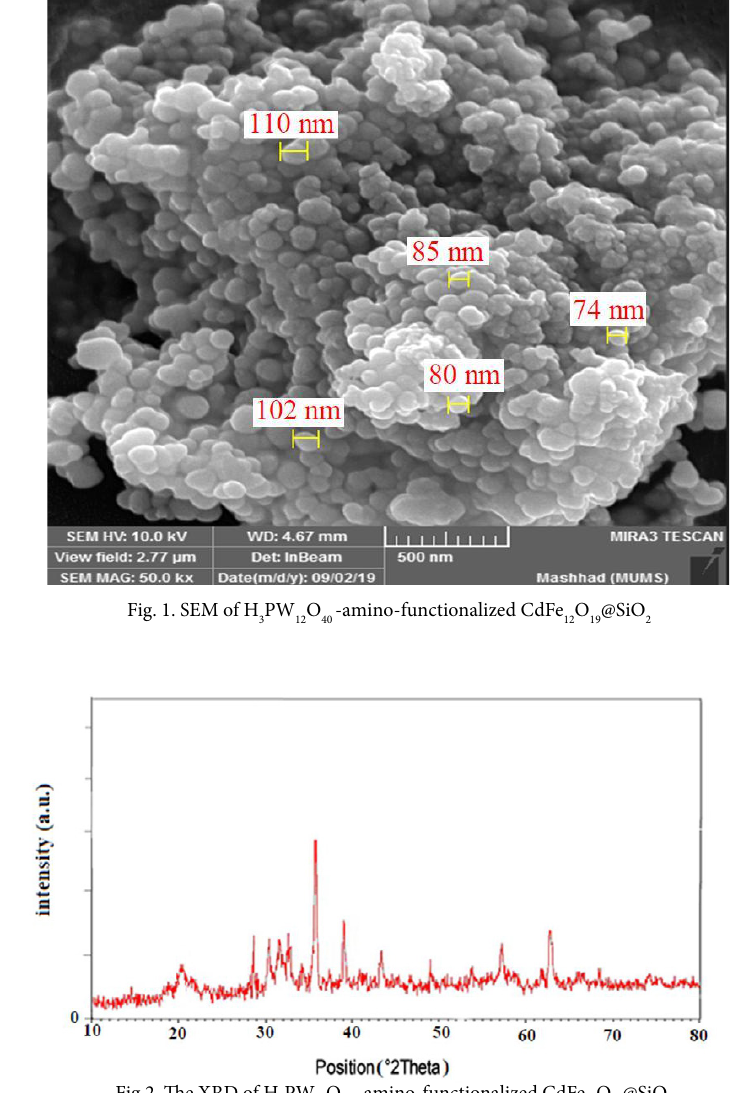
PW O -amino-functionalized CdFe 3 12 40